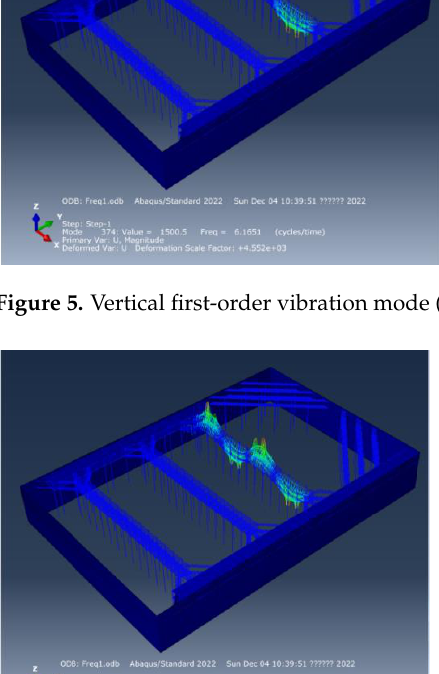
Figure 5. Vertical first-order vibration mode (6.16 Hz).